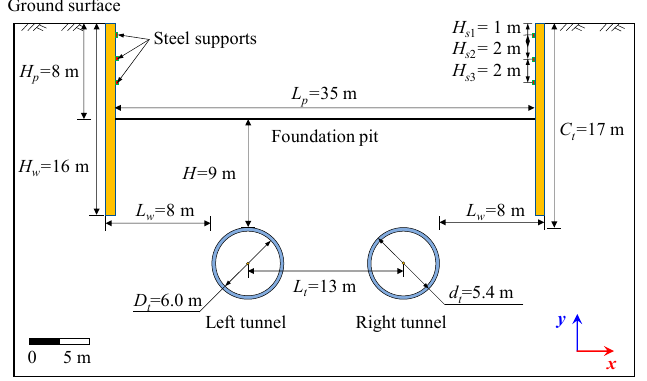
Figure 1. Spatial relationship between the foundation and twin-tube shield tunnels.